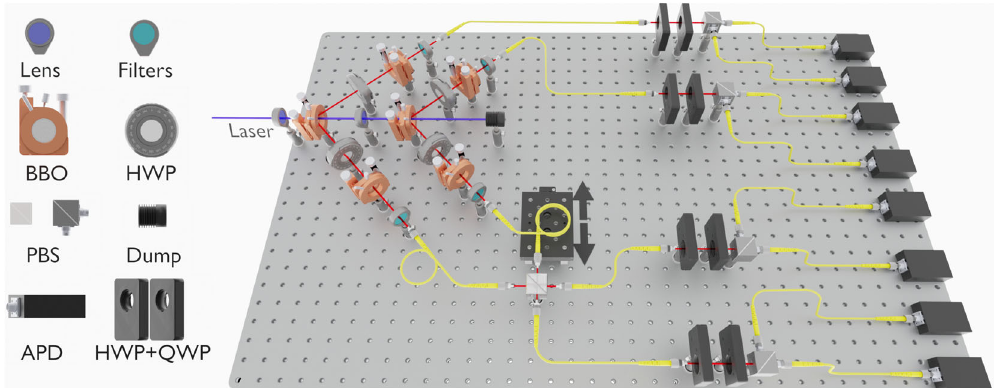
Fig. 3 Experimental setup. A fs-pulsed Ti:sapphire laser at 780 nm is fi rst frequency doubled and then passes through two non-linear β -barium-borate (BBO) crystals, each of which produces spatially separated single photons by type-II spontaneous parametric down- conversion (SPDC) in states: ψ (cid:2) j